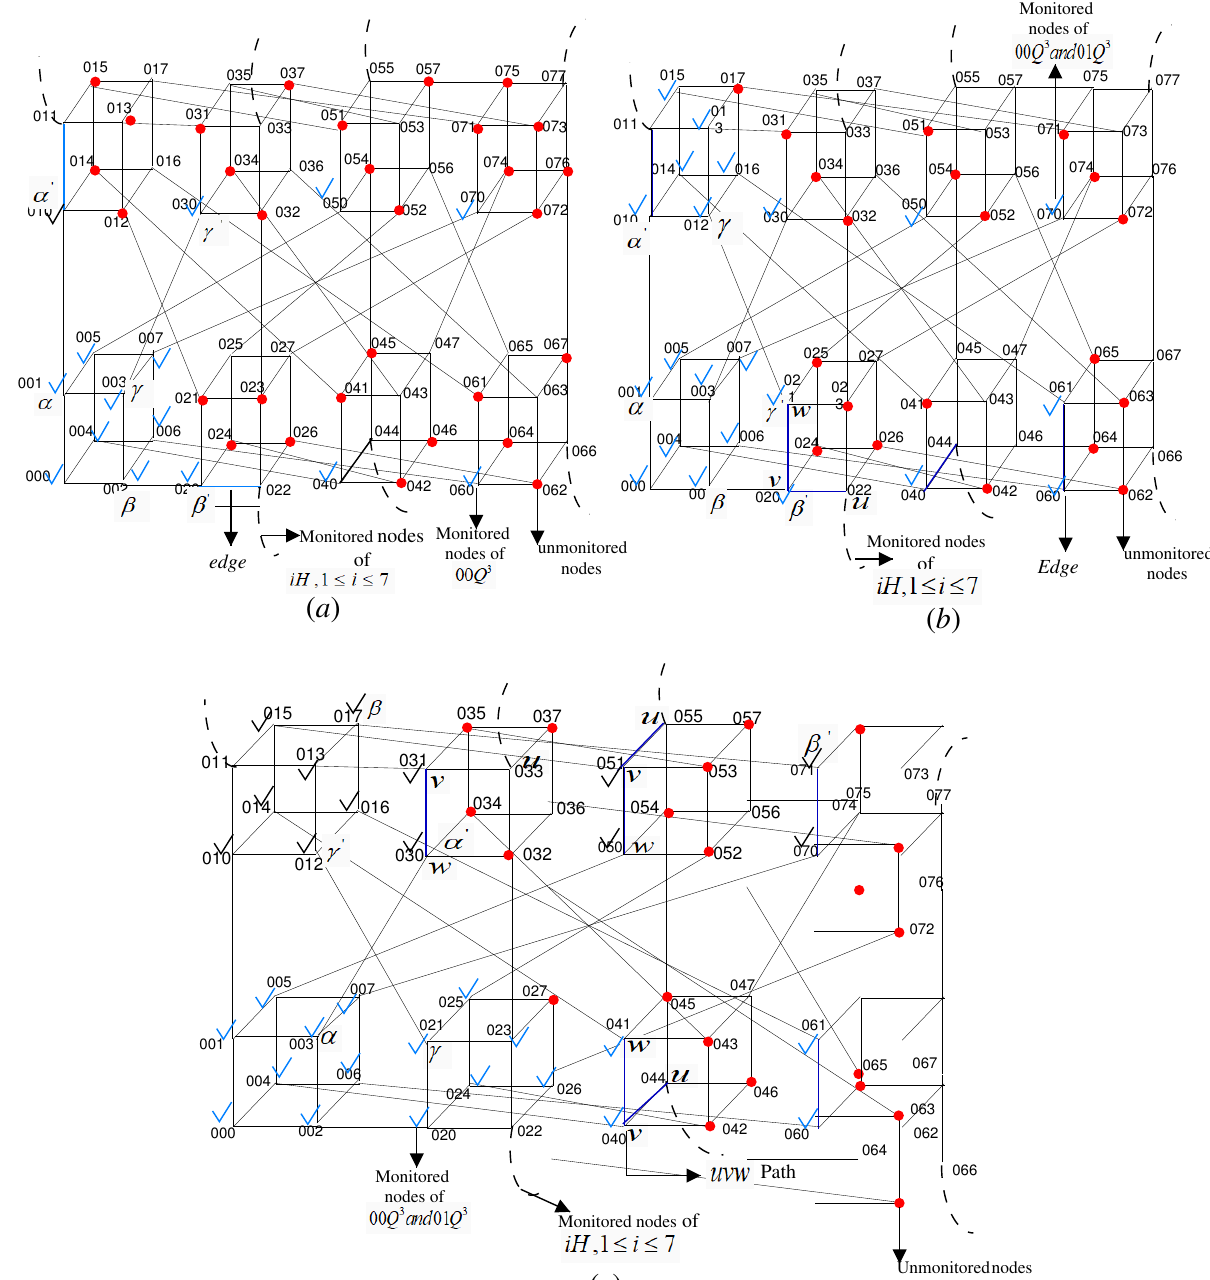
Figure 3. Circled vertices indicates in ( a – c ) be a PDS of 0 H 2 of H 3 . Lemma 3. The power domination number of H r , r ≥ 3 is at least 2 3 r − 4 . In other words, γ p ( H r ) ≥ 2 3 r − 4